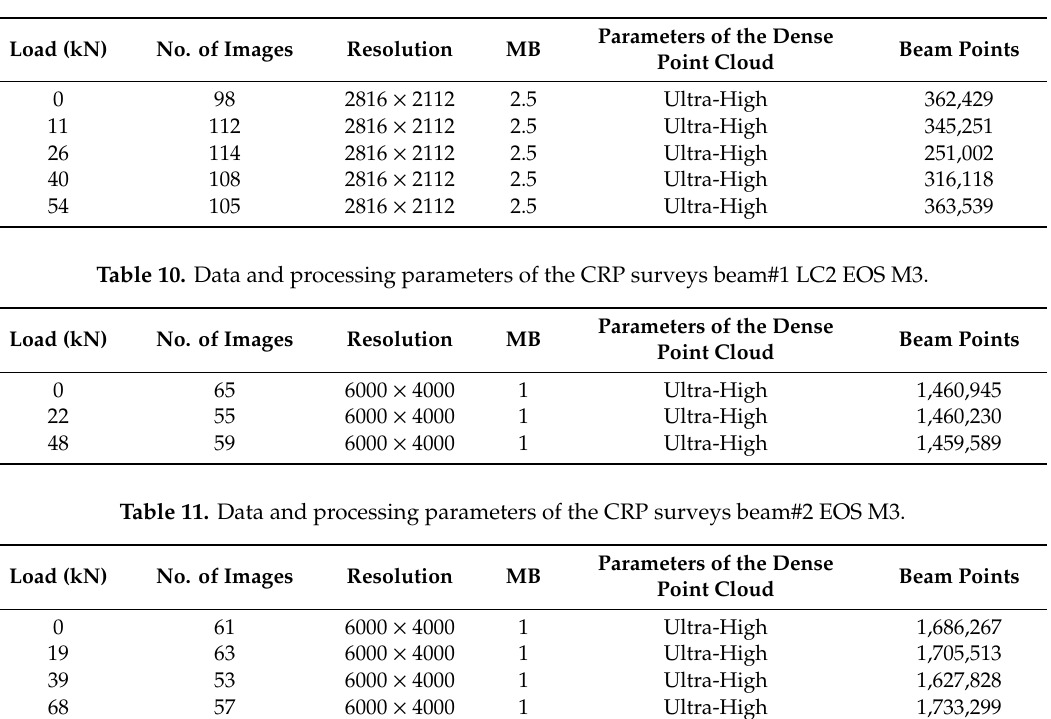
Table 9. Data and processing parameters of the CRP surveys beam#1 LC1 Powershot.